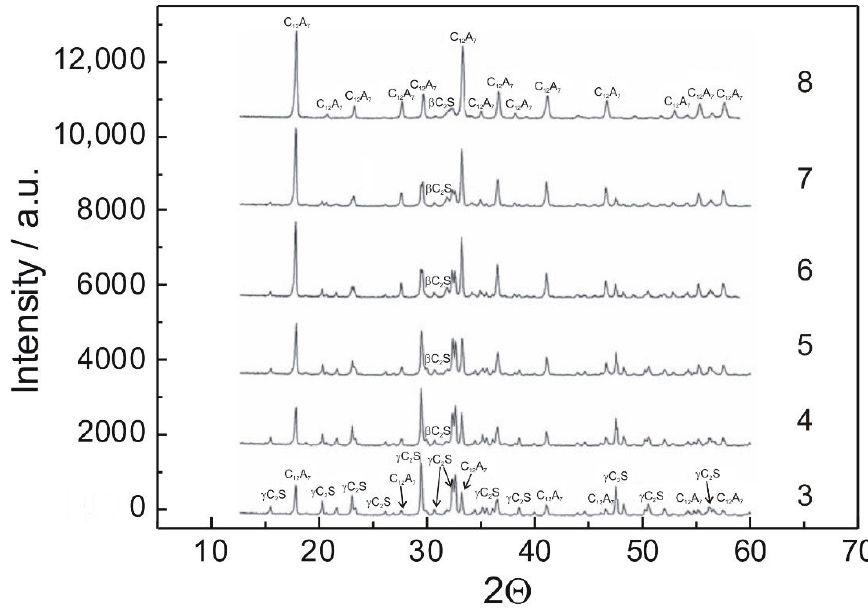
Figure 4. X-ray diffraction patterns obtained for samples 3, 4, 5, 6, 7 and 8.